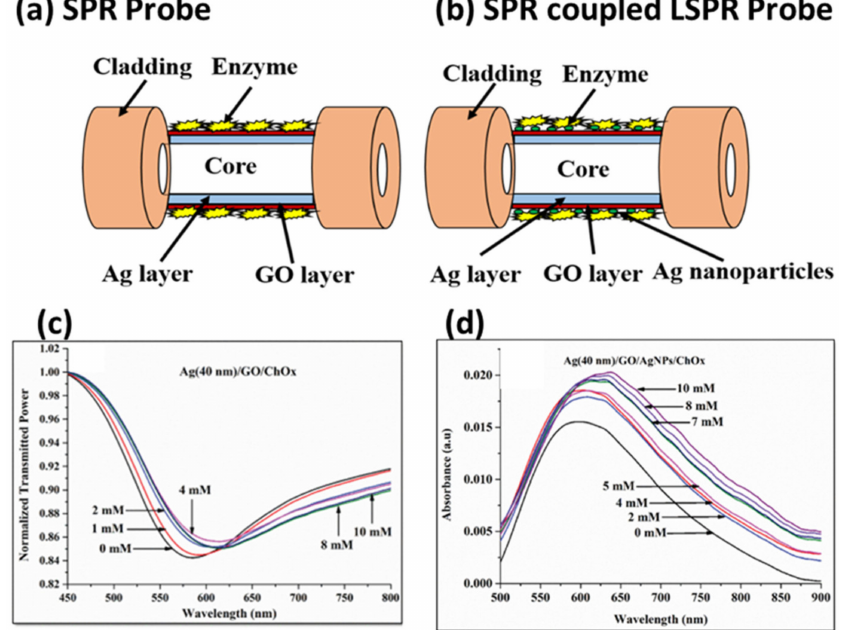
Figure 24. Schematic of ( a ) SPR, and ( b ) SPR-LSPR coupled probe for cholesterol detection. Response curves for ( c ) SPR, and ( d ) SPR-LSPR probes. Reprinted with permission from Ref. [152]. Copyright 2018 IEEE.